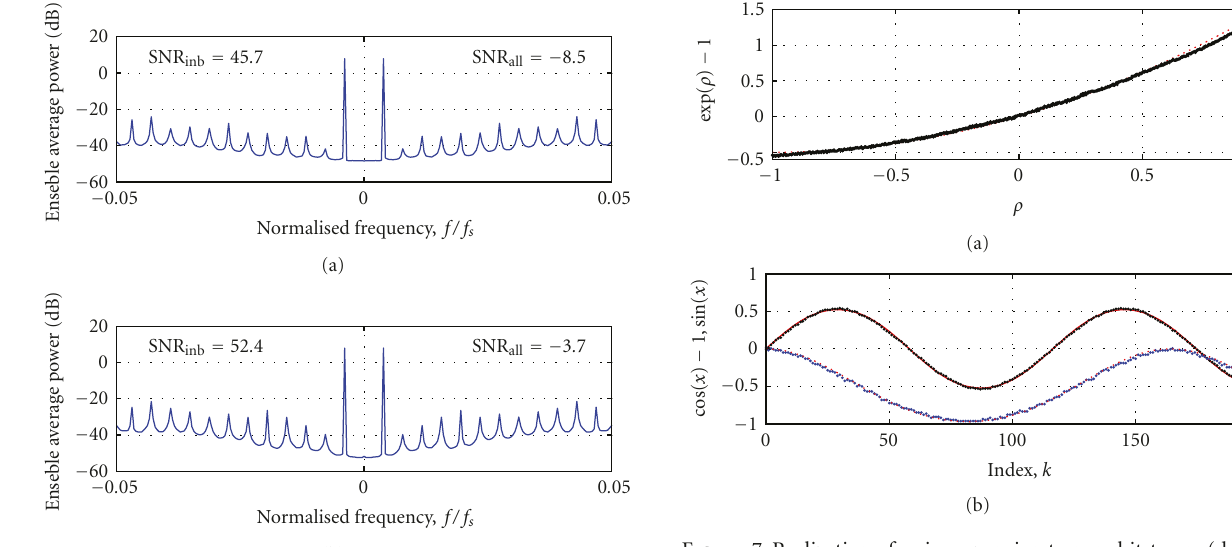
Figure 7: Realization of series expansion ternary bitstream (dotted) functions compared with their 32 bit precision counterparts (red): (a) Exponential function; (b) sine and cosine